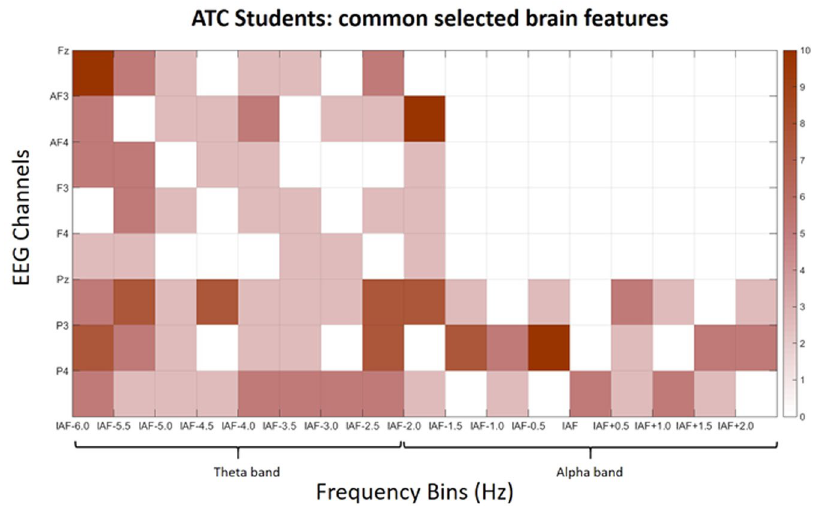
Figure 13. Percentages related to the brain features most commonly selected by the asSWLDA across the ATCO Students for the SRK-based cognitive control behaviours discrimination. White color means that brain features have not been selected at all. On the contrary, the red colors means that the brain features were selected more